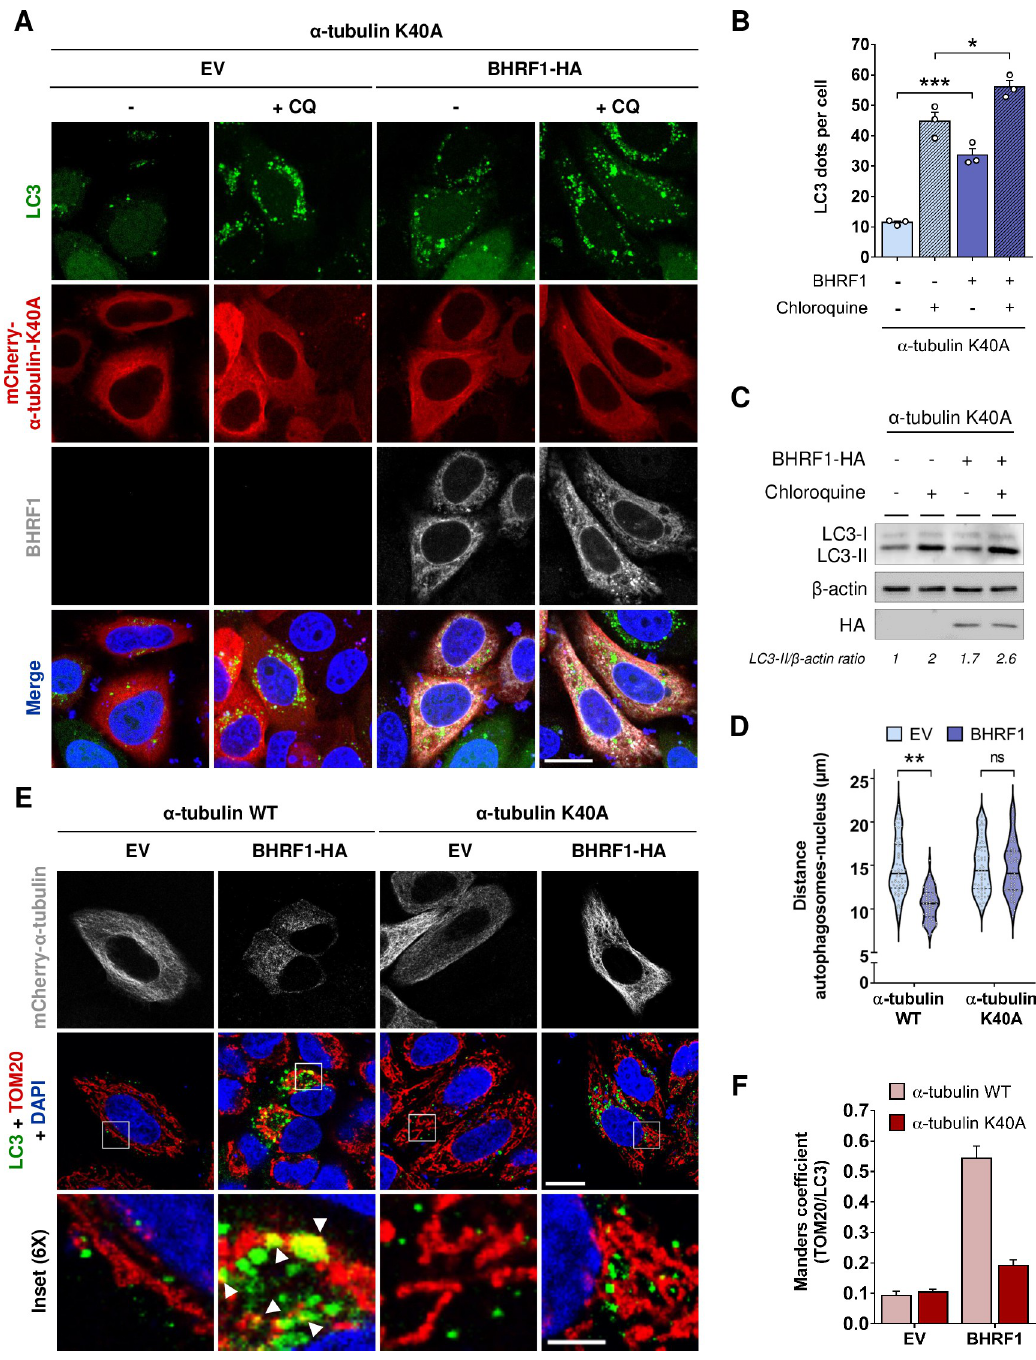
Fig 7. MT hyperacetylation is dispensable for BHRF1-pro-autophagic activity, but essential for mitophagy. HeLa cells were co-transfected for 24 h with plasmids encoding BHRF1-HA (or EV) and mCherry- α -tubulin K40A (or WT) and treated with chloroquine when indicated. (A) Confocal images. Cells were immunostained for BHRF1 and LC3 and nuclei stained with DAPI. Scale bar: 10 μ m. Images of cells transfected with mCherry- α -tubulin WT are presented in S9A Fig. (B) Quantification of LC3 dots (n = 30 cells per condition). (C) Immunoblot analysis of LC3 and BHRF1-HA expression. β -actin was used as a loading control. (D) Measurement of the distance between autophagosomes and nucleus (n = 60 cells from three independent experiments). (E) Confocal images of cells immunostained for TOM20 and LC3. Nuclei were stained with DAPI. Insets (6X) show colocalization events (see arrows). Scale bars: 10 μ m and 5 μ m for insets. (F) Colocalization level (Manders coefficient) between mitochondria (TOM20) and autophagosomes (LC3) (n = 30 cells per condition). Data represent the mean ± SEM of three independent experiments. ns = non-significant; � P < 0.05, �� P < 0.01; ��� P < 0.001 (Student’s t-test). https://doi.org/10.1371/journal.ppat.1010371.g007 PLOS Pathogens| https://doi.org/10.1371/journal.ppat.1010371 March 11,